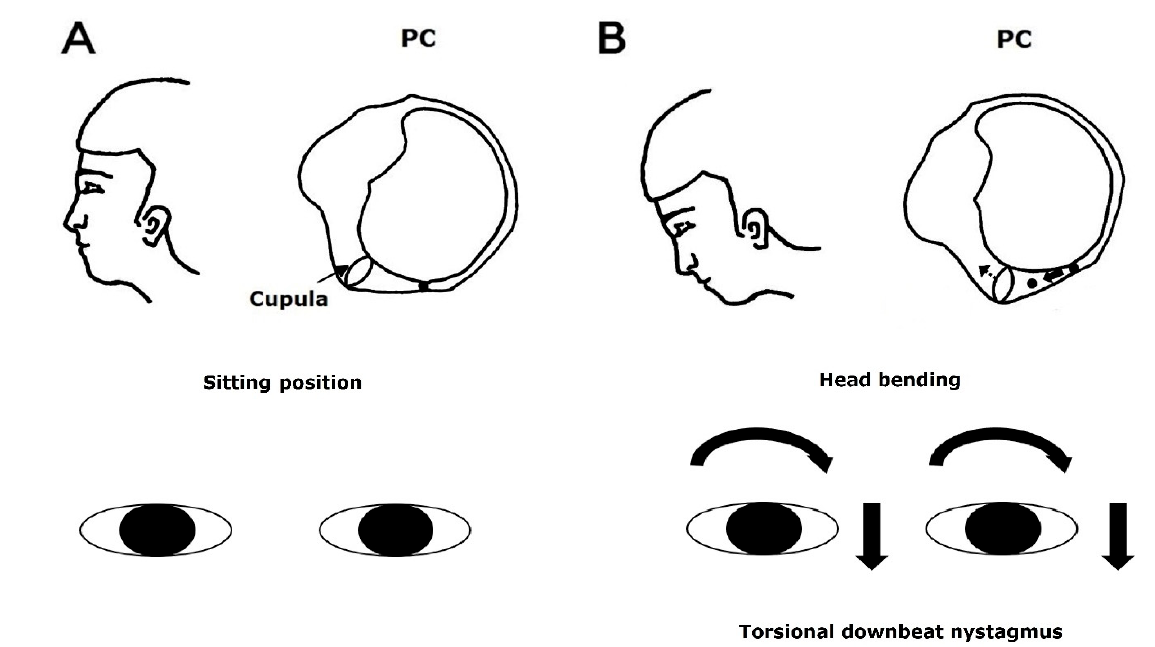
Figure 1. Use of the head bending maneuver to induce nystagmus in benign paroxysmal positional vertigo involving the left posterior canal. The free-floating otolithic debris in the posterior canal at sitting position ( A ) moves toward the cupula, which leads to ampullopetal defection of the cupula during head bending maneuver ( B ). The resulting nystagmus would be downward and torsional, with the upper poles of each eye beating toward the healthy (right) ear.